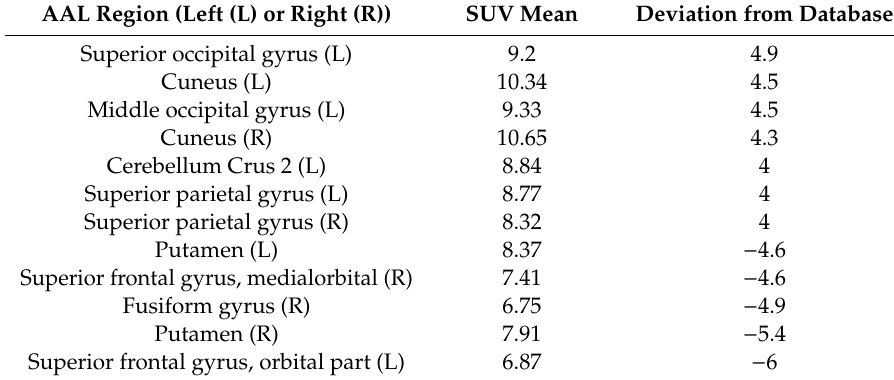
Table 2. Standard Uptake Value (SUV) mean and deviation from mean database in automated anatomical labeling (AAL) regions (positive deviation for hypermetabolism, negative deviation for